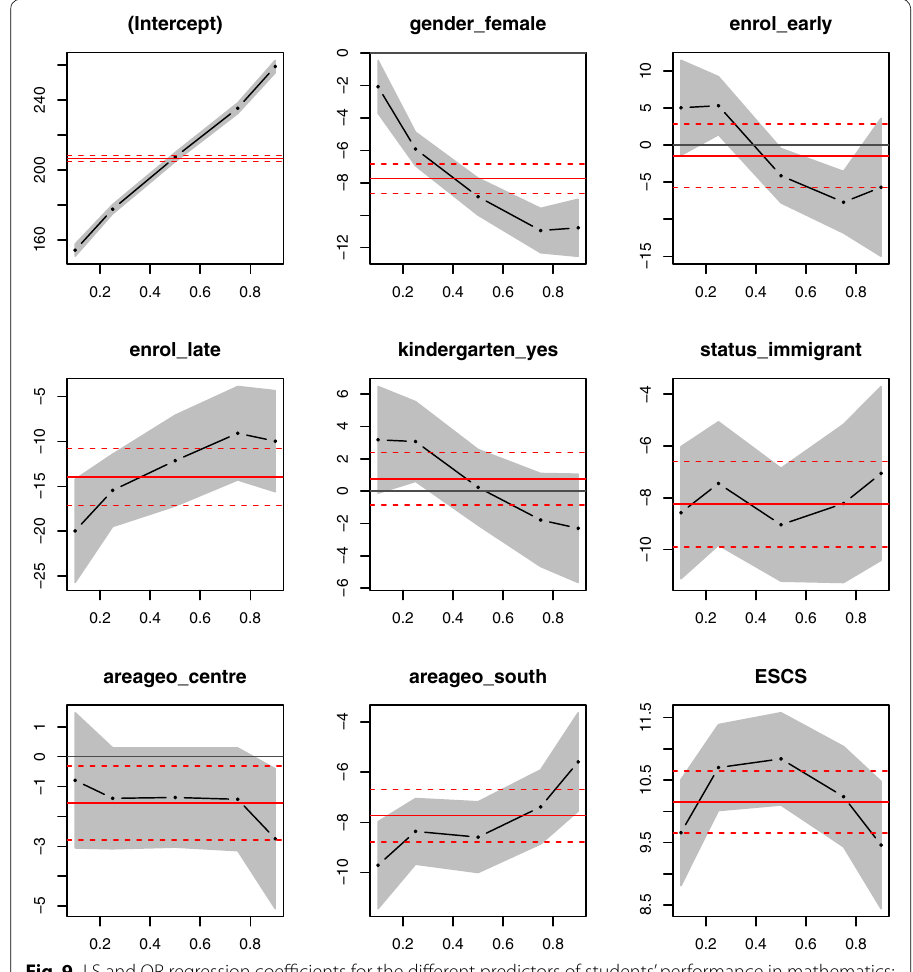
Fig. 9 LS and QR regression coefficients for the different predictors of students’ performance in mathematics: fifth-graders